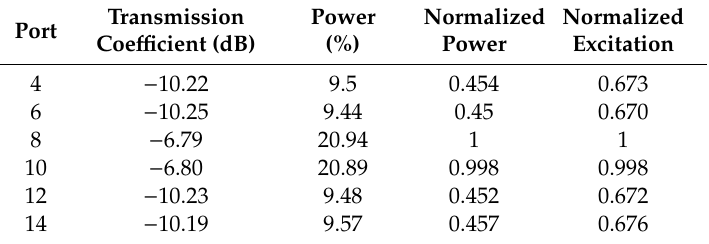
excitation of the respective ports in the power divider for SLL reduction from Figure